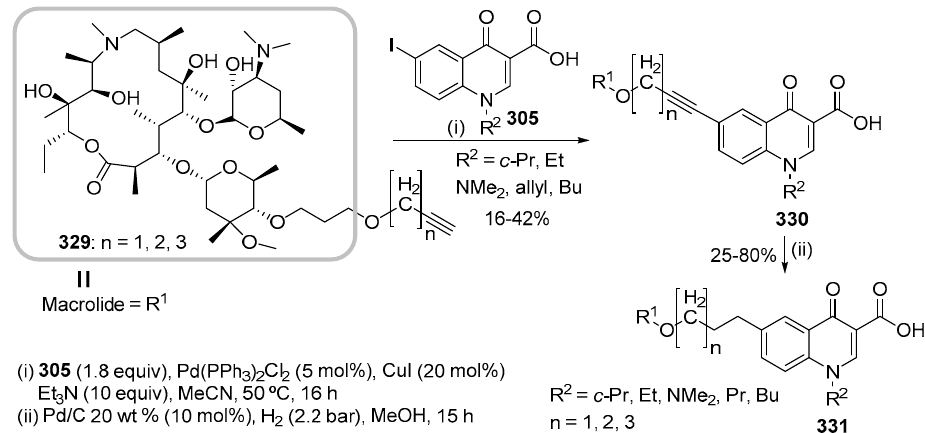
Scheme 104. Synthesis of macrolones 331 via Sonogashira reaction of macrolide 329 with